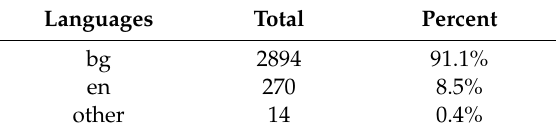
Table A5. Primary languages (bg).